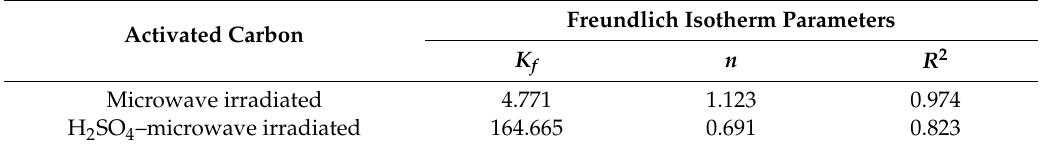
Figure 10. Freundlich isotherm plot fitted using POMB-retained ash: ( a ) microwave irradiated and ( b ) H 2 SO 4 –microwave irradiated.